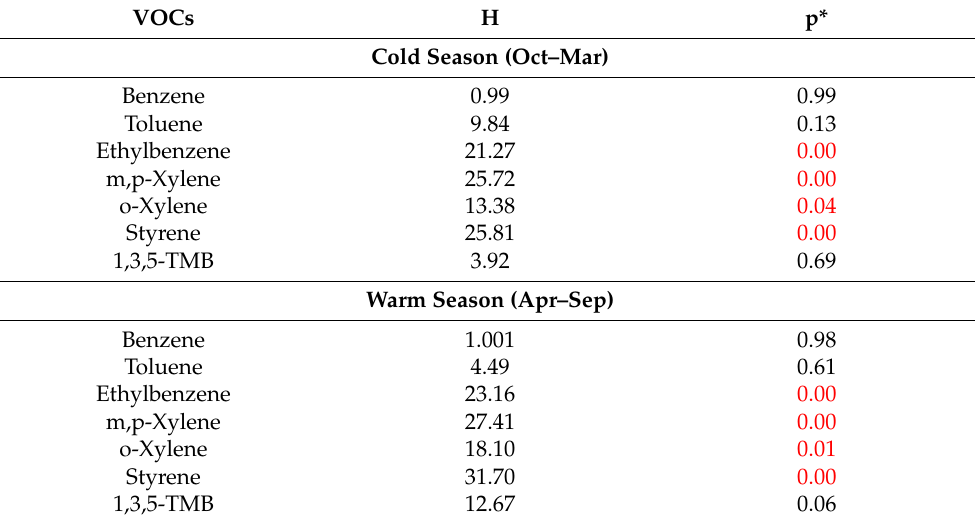
Table 5. Kruskal–Wallis test results for VOCs in the tested offices and outdoor. VOCs H